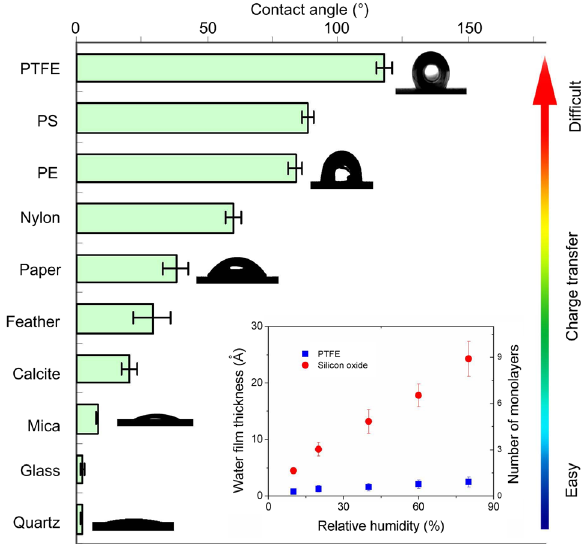
FIG. 5. Difficulty of charge transfer (qualitatively) versus contact angle between a 1 - μ L water drop and the insulator surface for several dielectric materials measured with an optical contact angle- measuring device. Inset: Number of monolayers of water mole- cules composing the water films on the surfaces of silicon oxide and PTFE, measured with an ellipsometer, versus air